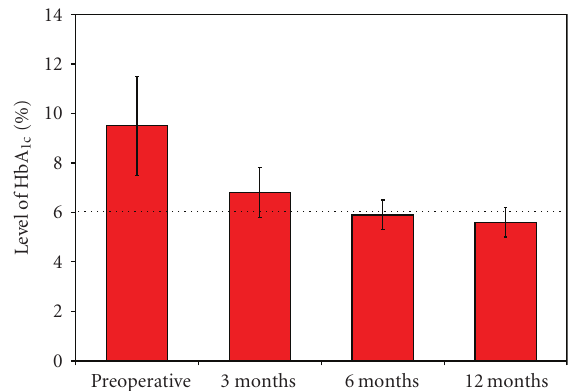
Figure 2: HbA 1c levels prior to BPD-DS and 3, 6, and 12 months after the operation. Red bars indicate the mean levels of HbA 1c , whiskers indicate standard deviation.